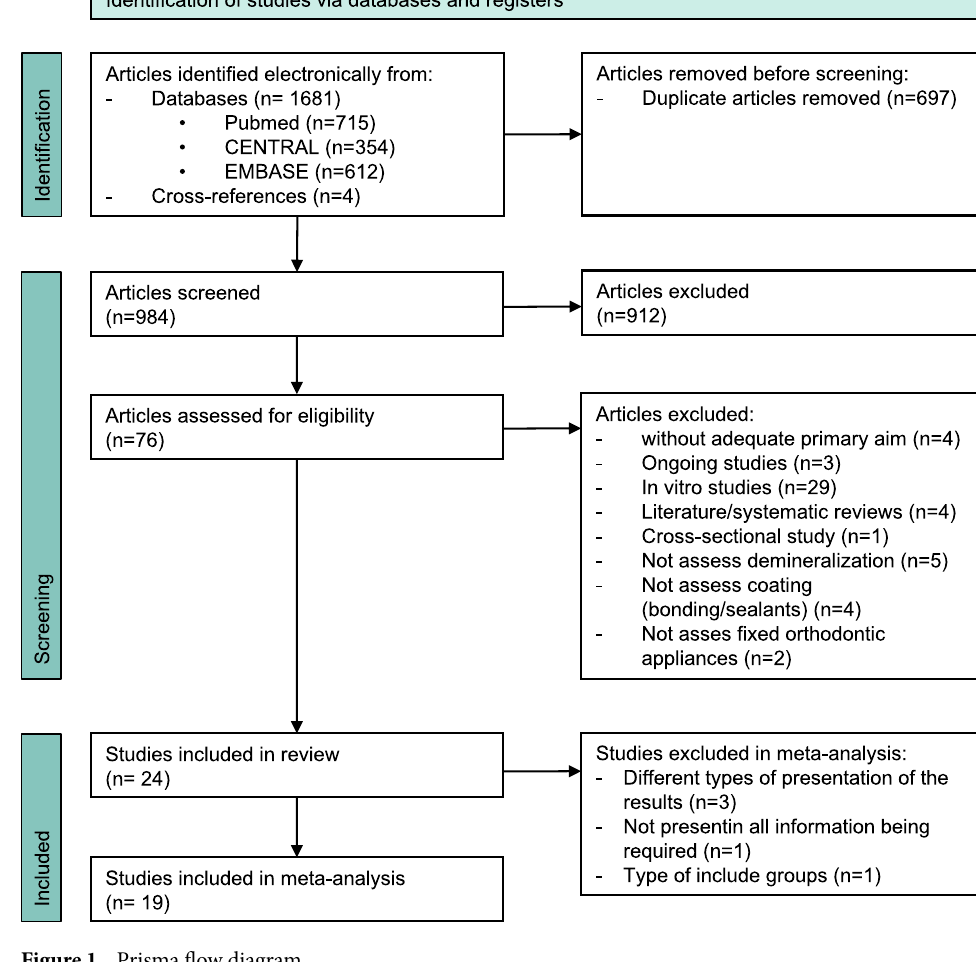
Figure 1. Prisma flow